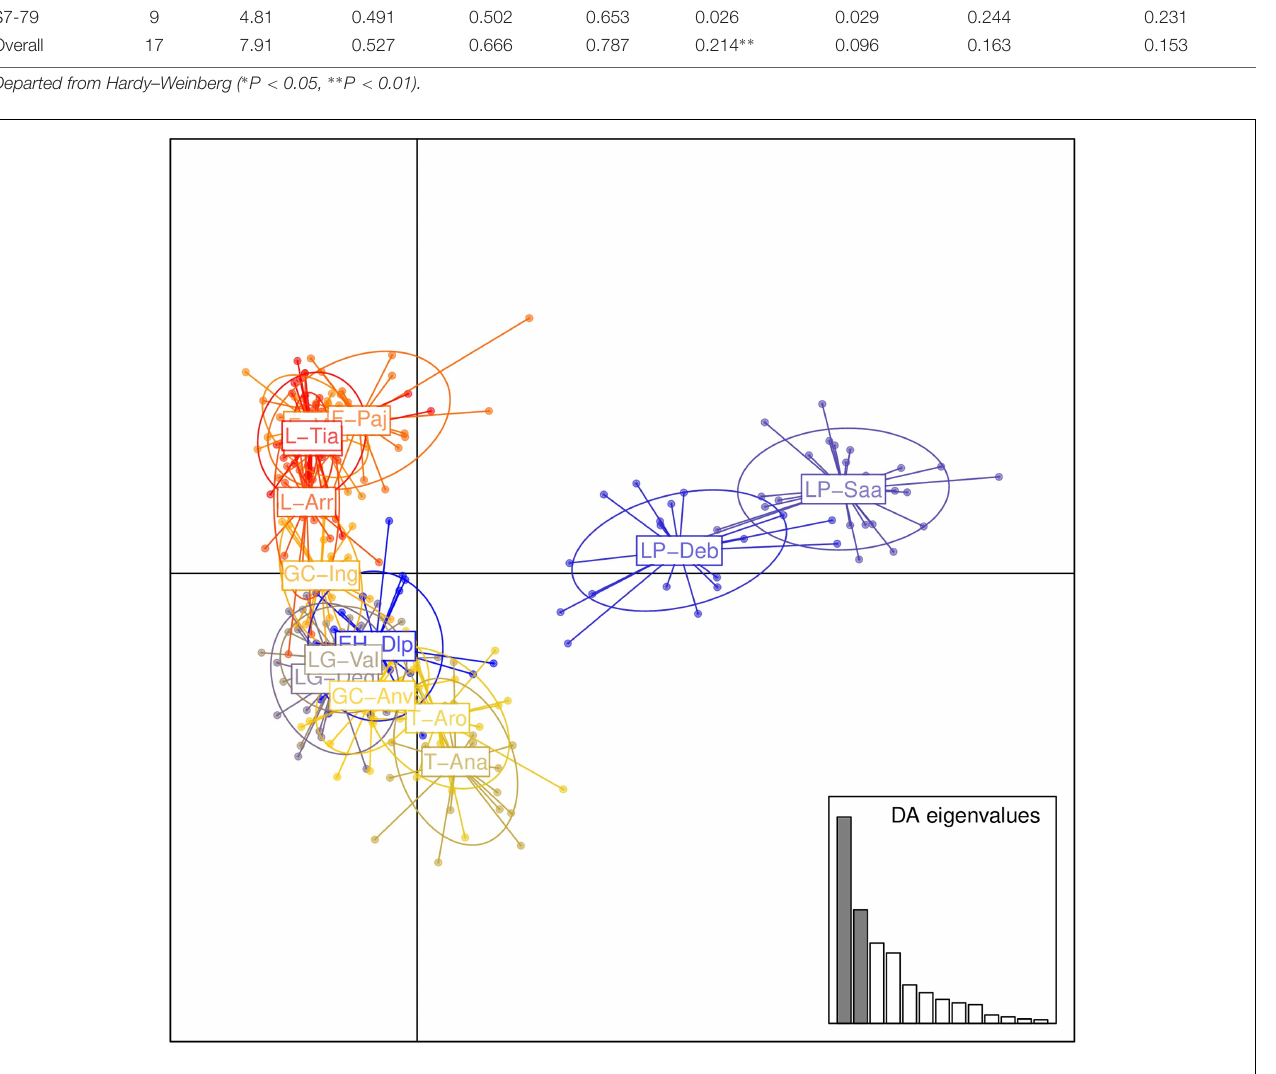
Number of alleles revealed per locus was 9–29, and observed heterogeneities were 0.304–0.702 ( Table 2 ). No evidence was observed that the seven microsatellites were affected by selection.